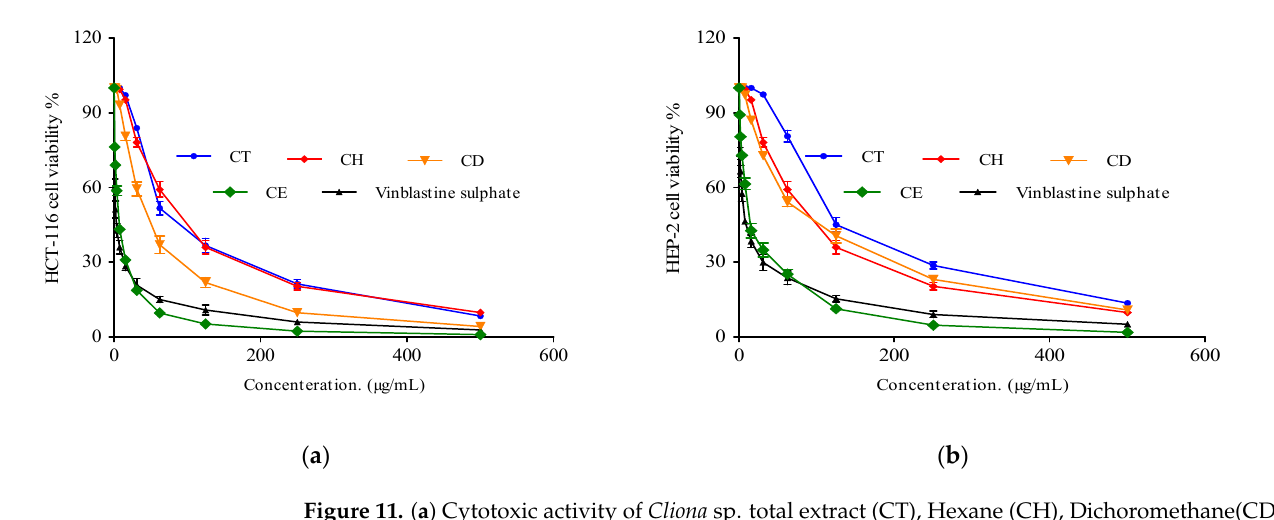
Figure 11. ( a ) Cytotoxic activity of Cliona sp. total extract (CT), Hexane (CH), Dichoromethane(CD), and Ethyle acetate (CE) fractions against the HCT-116 cell line at different concentrations. DMSO and vinblastine sulphate were used as negative and positive controls, respectively. ( b ) Cytotoxic activity of Cliona sp. total extract (CT), Hexane (CH), Dichoromethane(CD), and Ethyle acetate (CE) fractions against HEP-2 cell line at different concentrations. Data were analyzed by using one-way ANOVA and the statistical significance was calculated with Dunnett’s multiple comparisons test. A p -value < 0.05 was considered statistically significant. The data display the mean ± SD of three biological replicates. Table 5. Half maximum inhibitory concentration (IC 50 ) of Cliona Sp. Total extract (CT), Hexane (CH), Dichloromethane (CD), and Ethyl acetate (CE) fractions in cell viability of HCT-116 and HEP-2 cells after the treatment for 48 h, as measured by MTT assay. The data are presented as µ g/mL. IC 50 ( µ g/mL) Cell Line Tested Total Extract of Cliona sp. and Its Fractions